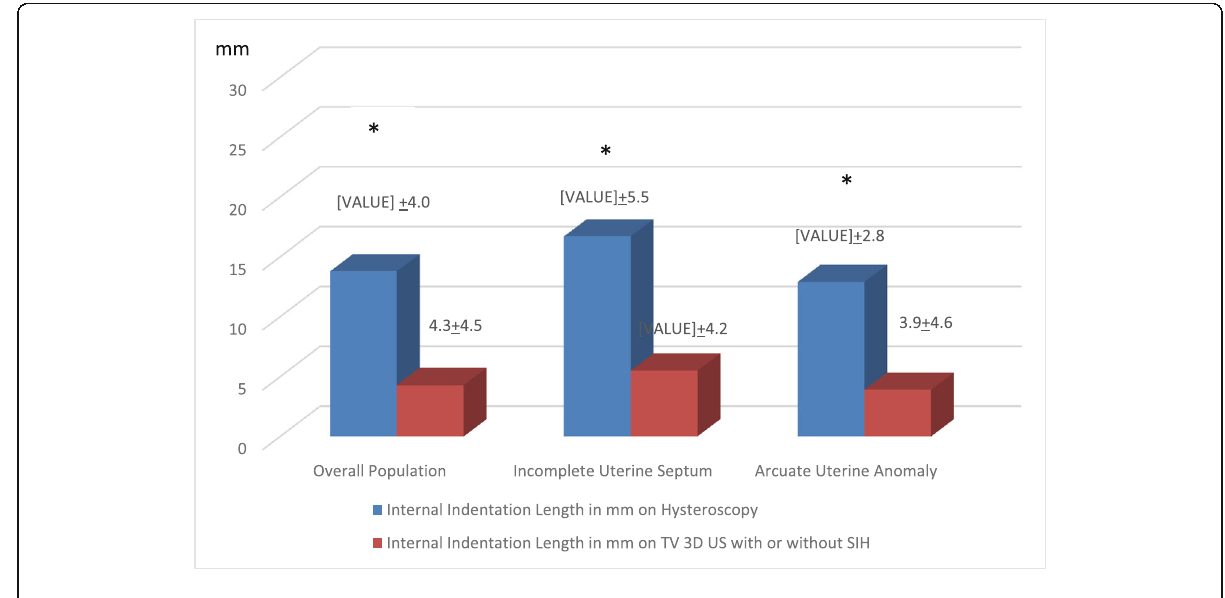
Fig. 4 Comparison between the mean IILFM measured in millimeter on hysteroscopy and on TV 3D US with or without SIH, in patients with IUS, significant AUA, and in the overall population in all